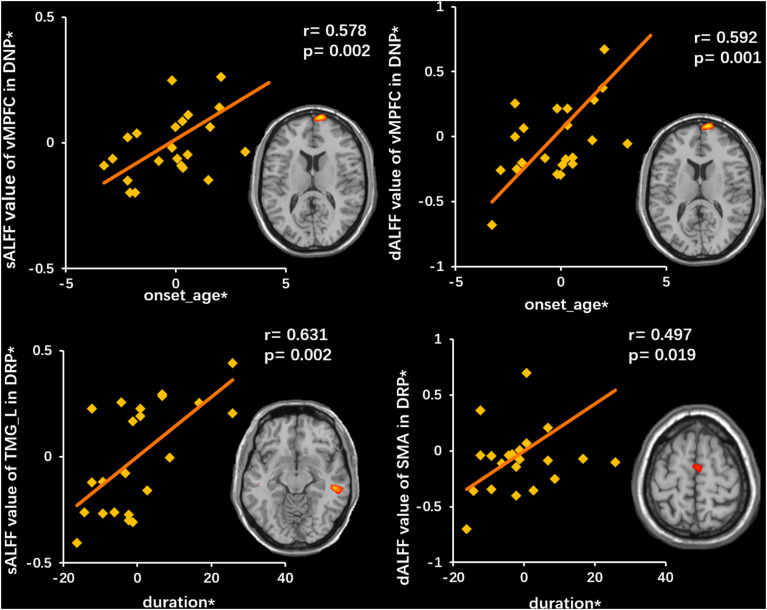
Correlations between neuroimaging variates and clinical features. The top row illustrates a positive correlation between sALFF (left) and dALFF (right) of vMPFC and onset age in DNP. The bottom row illustrates a positive correlation between sALFF (left) of TMG_L and dALFF (right) of SMA and duration. The asterisk (*) indicates coordinate values controlling for the influence of gender.